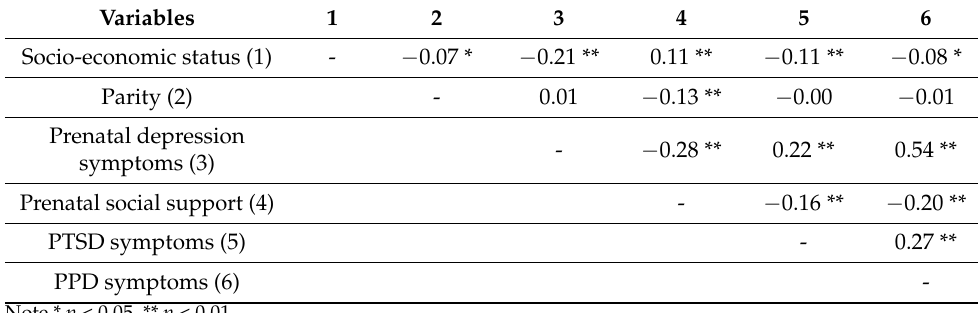
Table 2. Bivariate correlations between demographics and pre-post maternal distress variables.